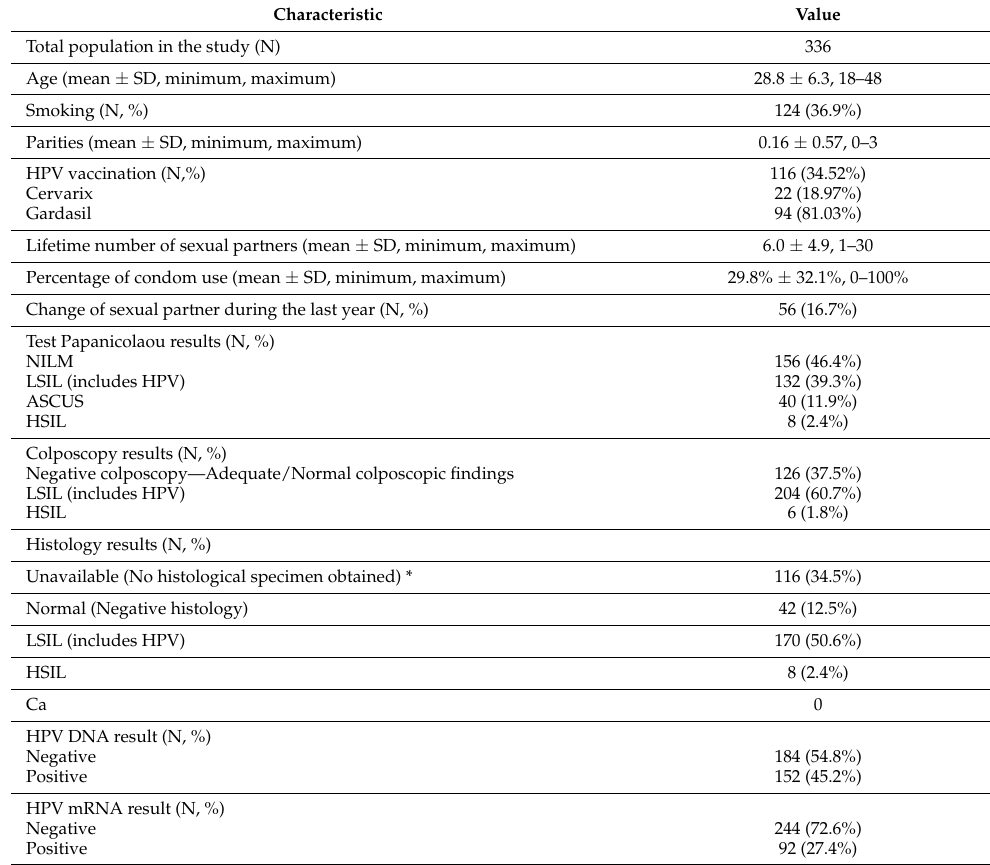
Table 1. Baseline characteristics of the study